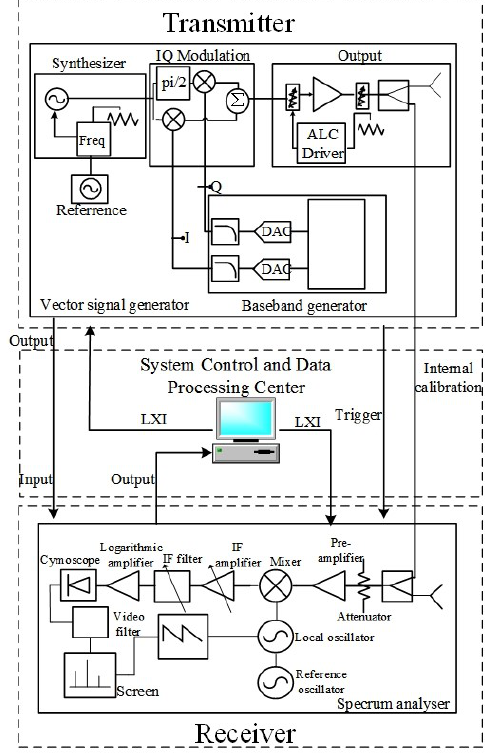
Figure 9. The connection block diagram.